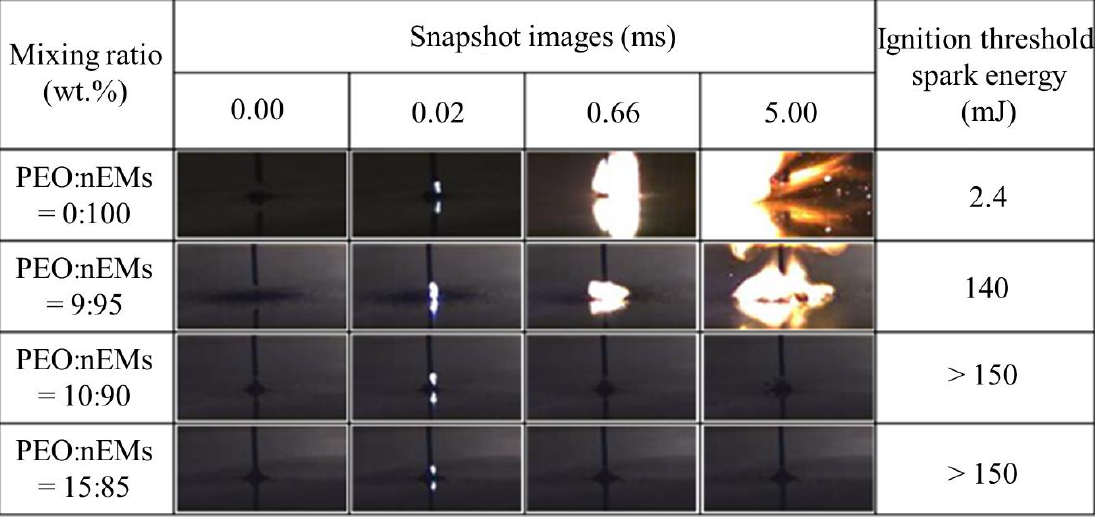
Figure 5. Explosion-induced pressure traces of ignited PEO/nEM composites with different PEO contents in the PCT system.